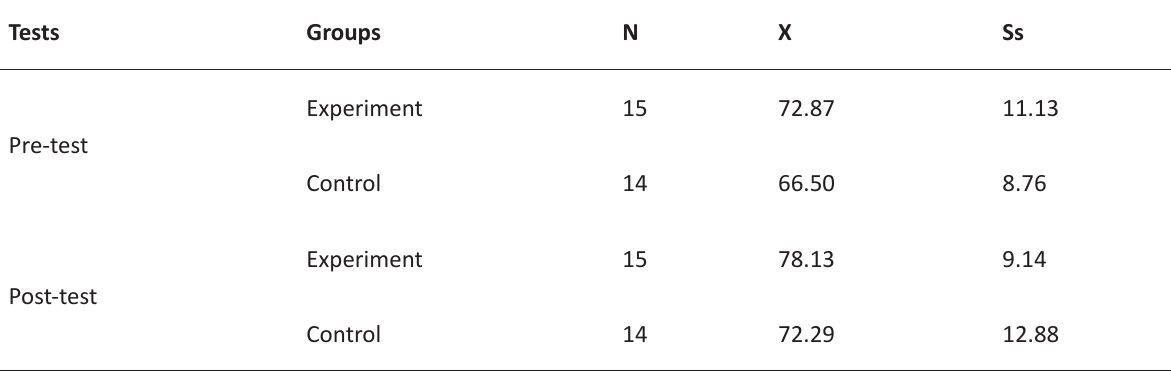
Table 2. Comparison of Visual Attention of Pre and Post Test Results of Boxers